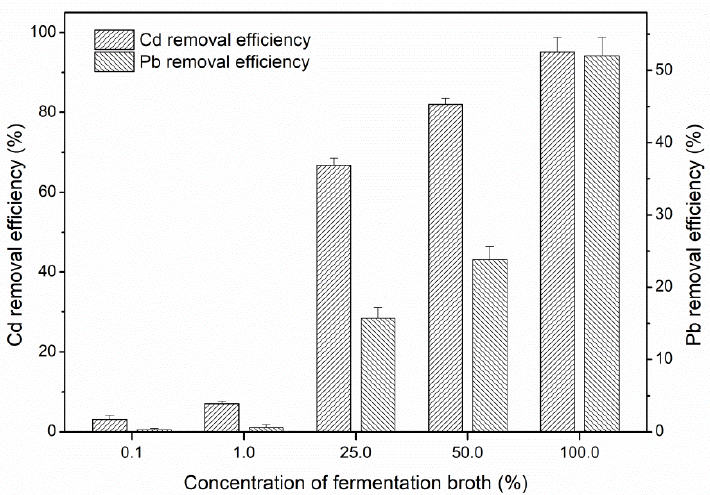
Figure 3. Removal of heavy metals from contaminated soil at different concentrations ( v / v %) of S. bombicola fermentation broth. S. bombicola fermentation